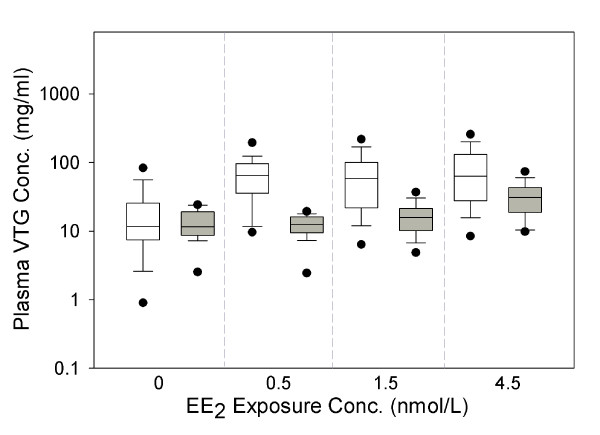
Comparison of model predictions with measured data in female FHMs exposed to EE2. n = 28 at each sampling time. White boxes represent model predictions, and grey boxes represent measured data [42]. The x-axis represents EE2 concentrations in ng/L. The solid line within the box marks the median; the boundary of the box farthest from zero indicates the 75th percentile; the boundary of the box closest to zero indicates the 25th percentile; the whisker (error bar) farthest from zero marks the 90th percentile; whisker (error bar) closest to zero marks the 10th percentile; the circle farthest from zero marks the 95th percentile; and the circle closest to zero marks the 5th percentile.